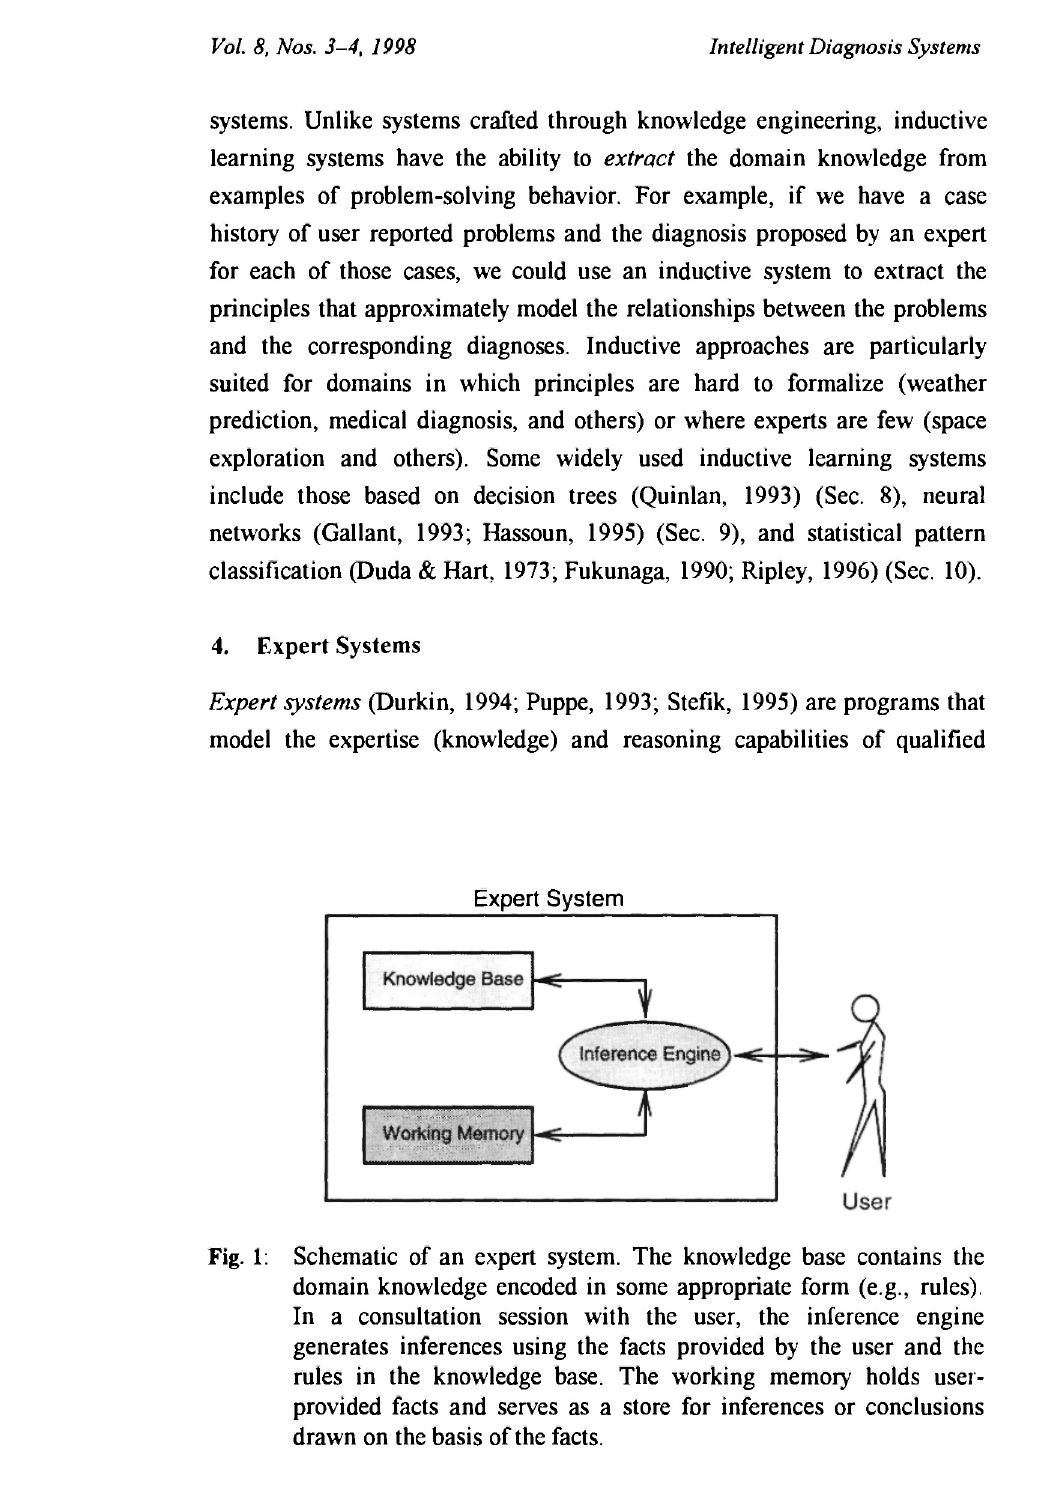
Fig. 1: Schematic of an expert system. The knowledge base contains the domain knowledge encoded in some appropriate form (e.g.,